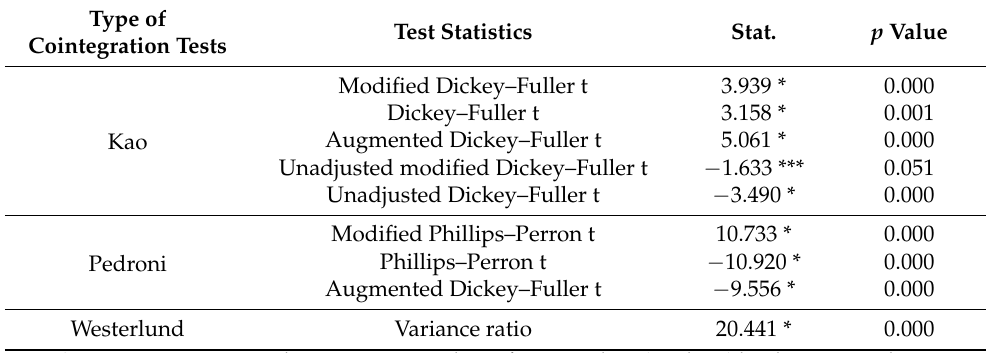
Table 5. The findings of panel data cointegration